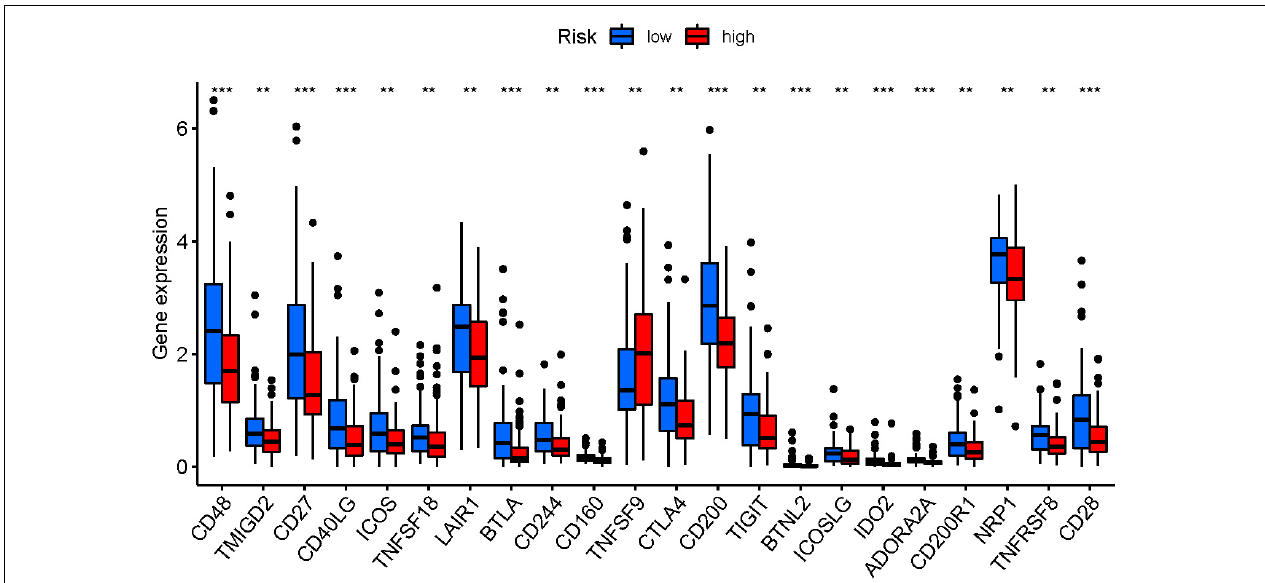
FIGURE 7 | Expression of immune checkpoints among high- and low-risk pancreatic cancer groups. P -values were showed as: ns, not significant; ** P < 0.01; *** P <